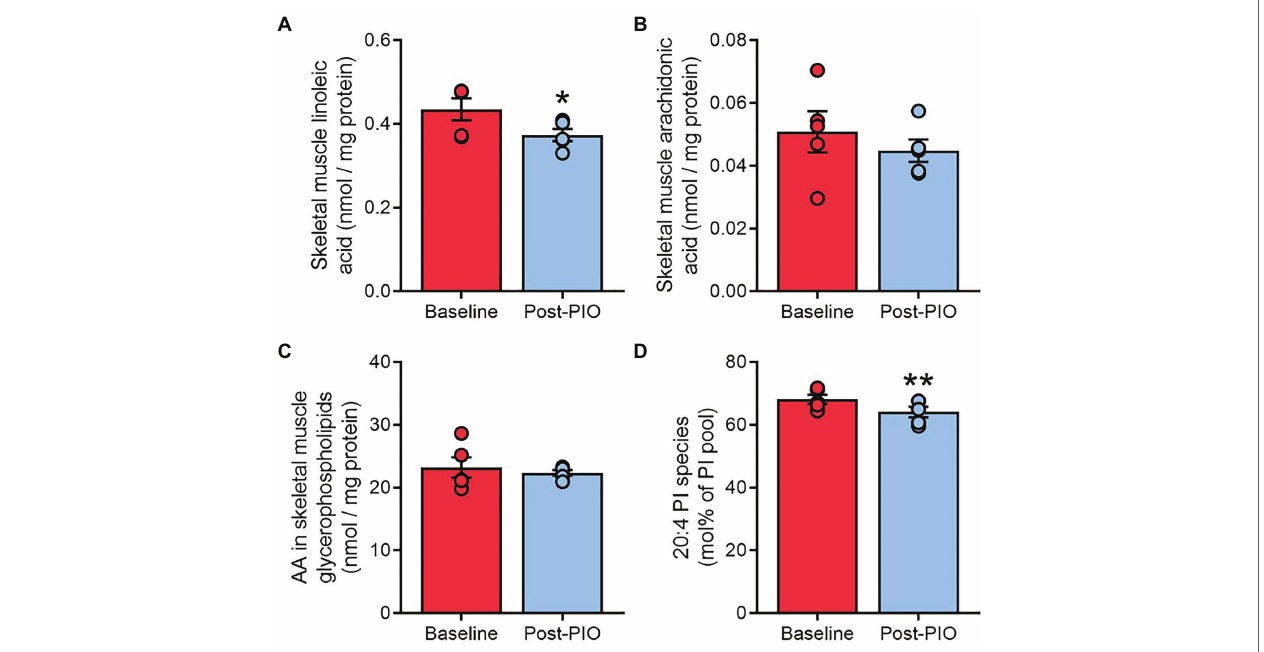
FIGURE 6 | Pioglitazone-induced changes in adipose tissue are partially recapitulated in skeletal muscle. Content of free linoleic acid (A) and arachidonic acid in unesterified form (B) or esterified in glycerophospholipids (C) , or as a fraction of the phosphatidylinositol pool (D) , in paired skeletal muscle samples at Baseline (red) and Post-PIO (blue). * p < 0.05, ** p < 0.01 vs. Baseline. Data are mean ± standard error (filled bars) and individual values (filled circles) for n = 5